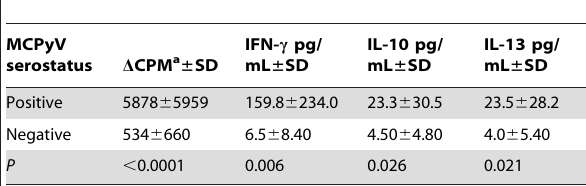
Table 3. Comparison of HBoV-specific proliferation and cytokine responses among MCPyV seropositive and –seronegative subjects at 2.5 m g/ml antigen